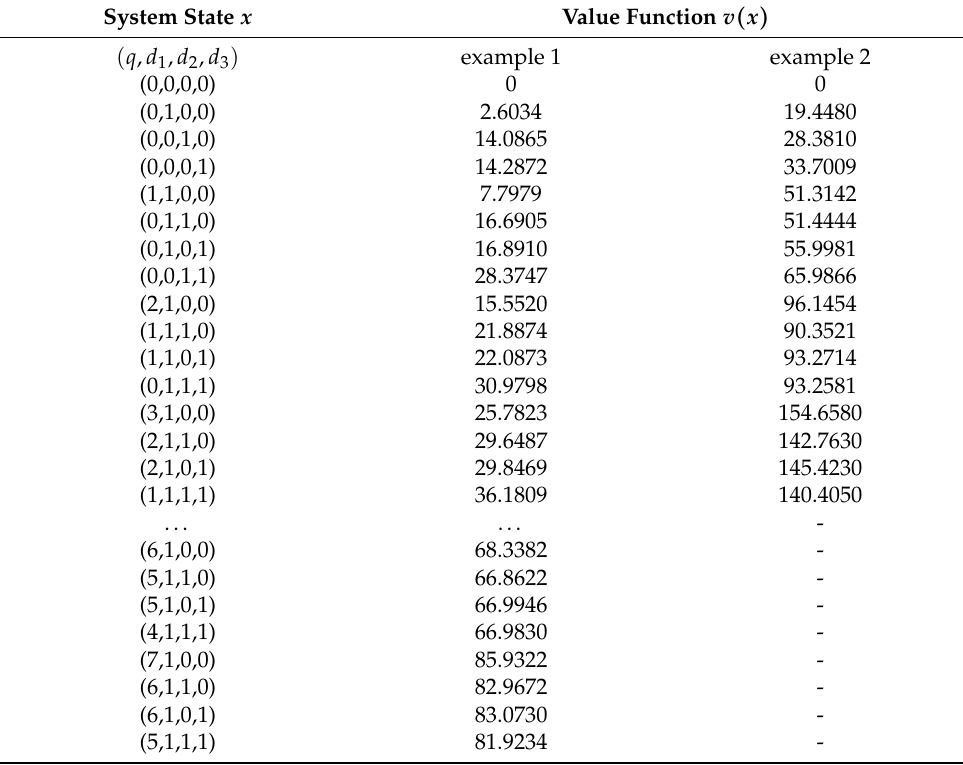
Table 3. Value function for system